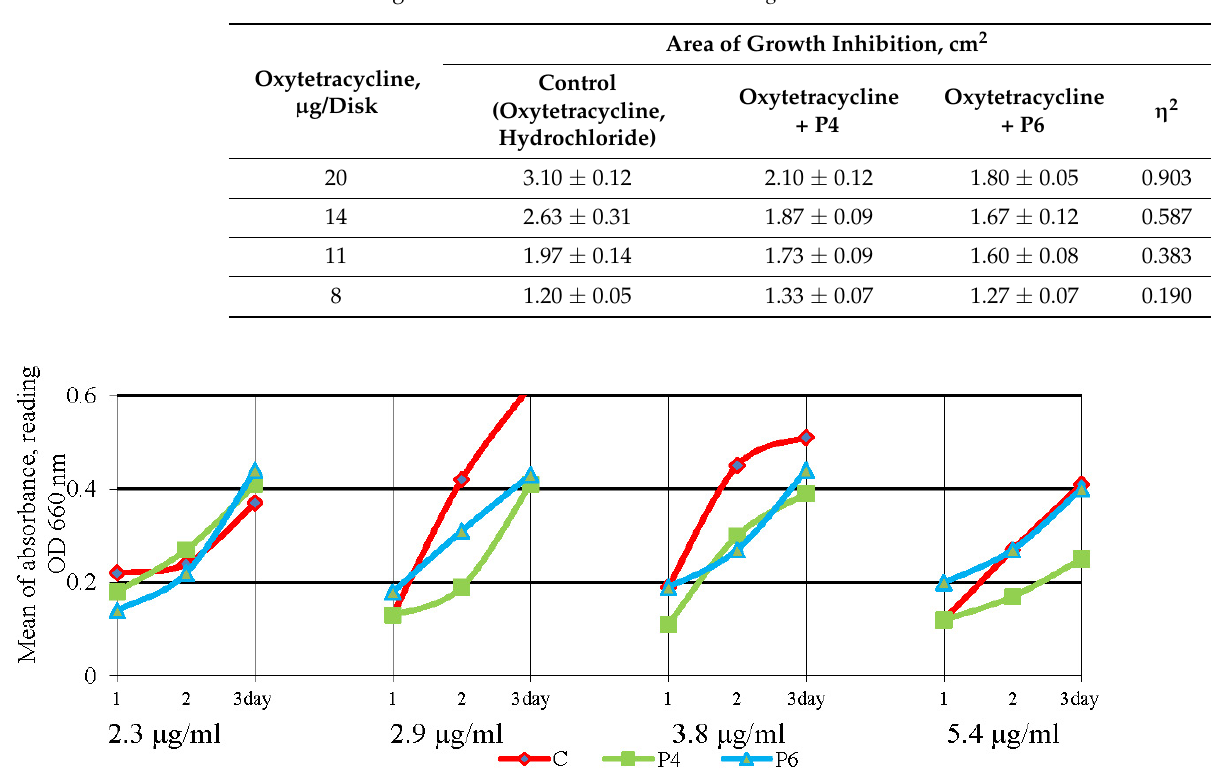
Figure 11. Growth inhibition of Pseudomonas aeruginosa . Table 3. Area of growth inhibition of Pseudomonas aeruginosa .